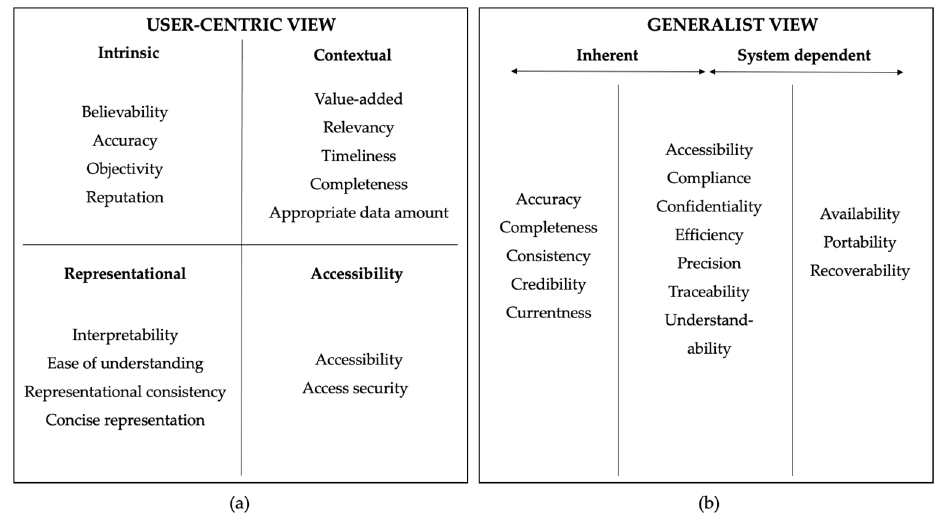
Figure 2. Data Quality dimensions from a ( a ) user-centric [12] and ( b ) generalist view [33], own illustration.